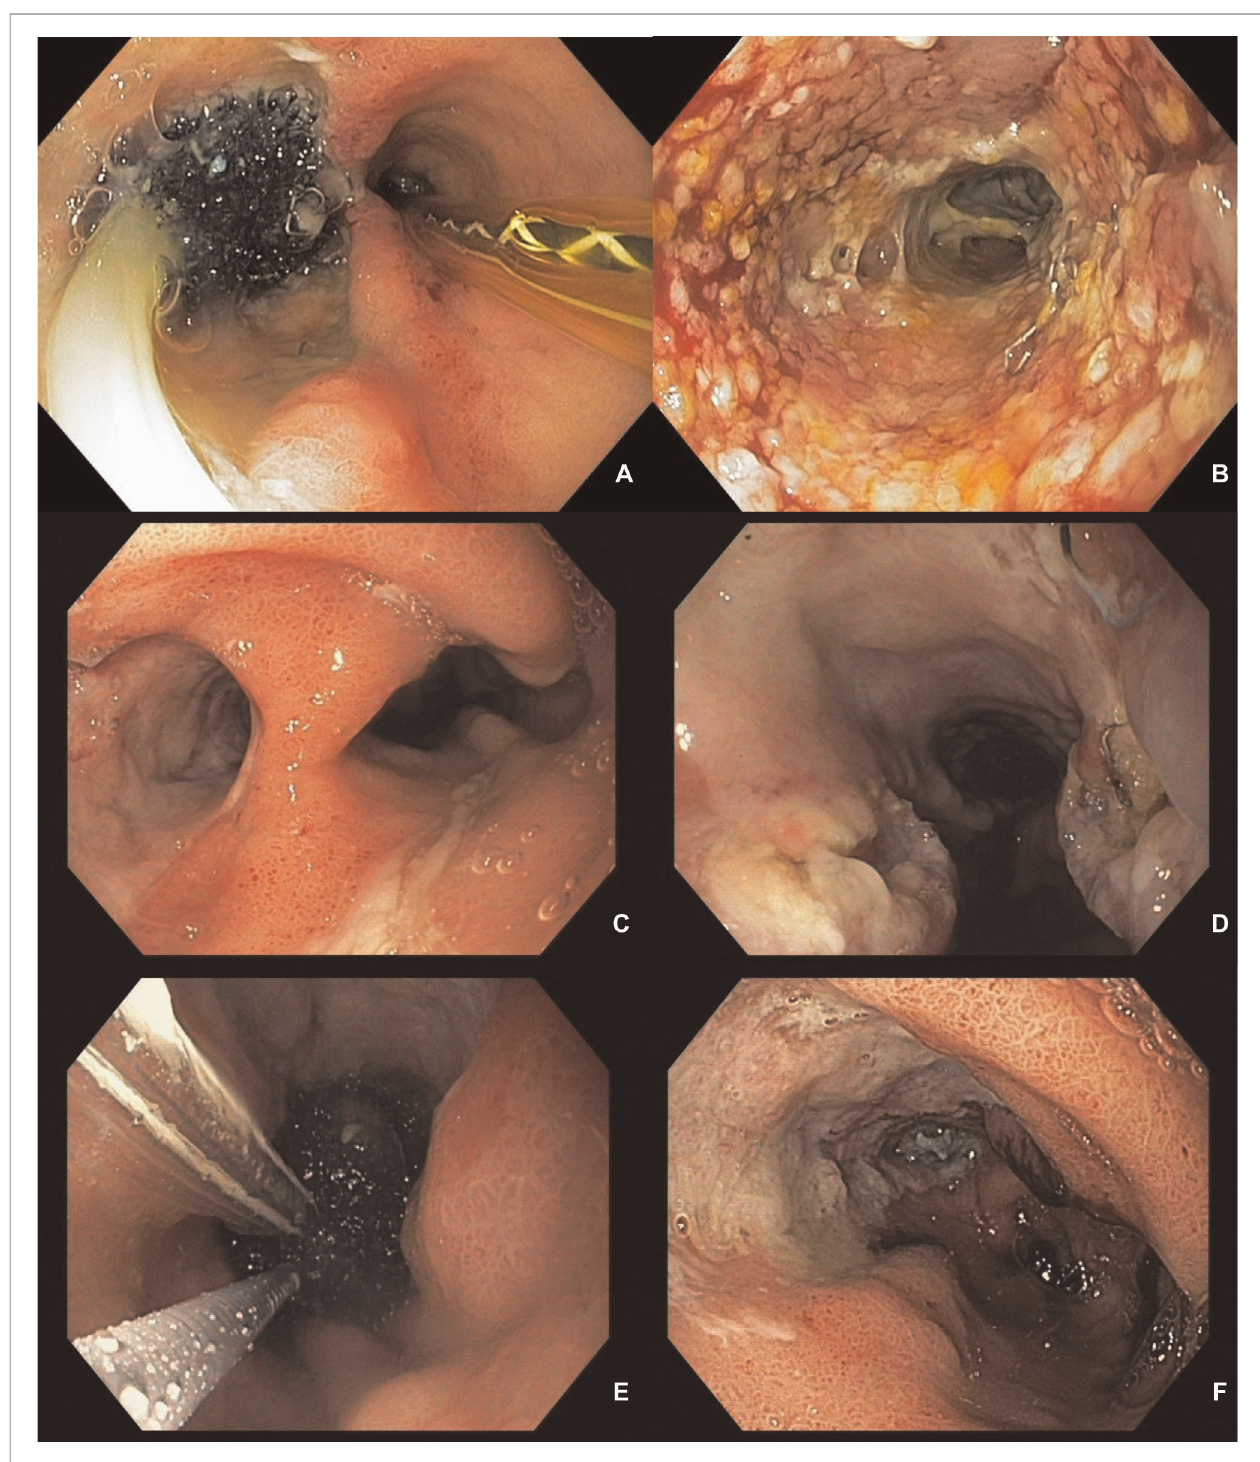
FIGURE 3 | ( A – F ) Creation of an optimal access route to the leakage defect in a patient after sleeve gastrectomy. Endoscopic pictures of a female patient with a chronic large defect of the proximal stapler line after sleeve gastrectomy transferred to our institution for complication management. Initial endoscopy found a 40× 15 mm long EVT sponge in an approx. 12 cm long and 15mm wide paragastral defect. A gastric tube was placed intraluminary of the sleeve stomach ( A ). In the area of the defect ground, no suction marks but necrosis and fi brin deposits were detected ( B ). Necrosis and fi brin were removed using forceps and a brush. In a further step, in order to enable wide endoscopic access to the defect ground the canal was opened towards the gastric tube using a clutch cutter (Fjui fi lm). ( C,D ) After further EVT ( E ), a gastric tube with a continuous lumen of approx. 4 cm is found. The approximately 12 cm long former defect canal is completely epithelialized in the proximal half and almost completely epithelialized in the distal area ( F